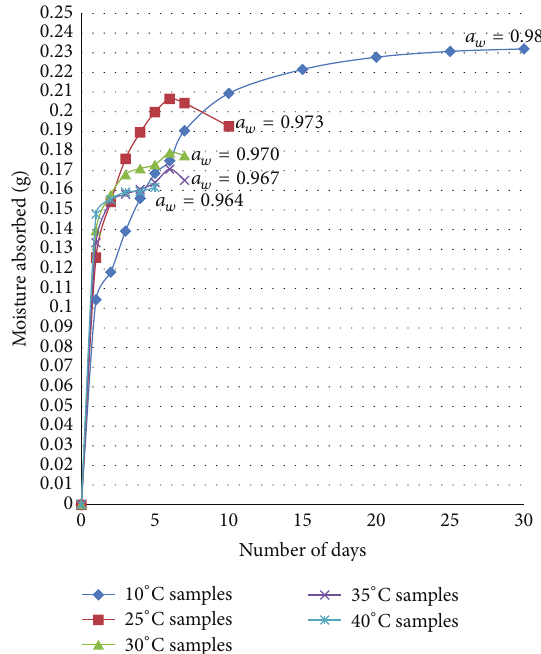
Figure 5: Soy/PE fiber samples stored with potassium sulfate salt solutions at different temperatures (10 ∘ C, 25 ∘ C, 30 ∘ C, 35 ∘ C, and 40 ∘ C). Ultimate moisture absorbed during storage in different rel- ative humidities (0.982, 0.973, 0.970, 0.967, and 0.964, respectively). Each data point denotes a mean value of 6 samples in 3 replications.